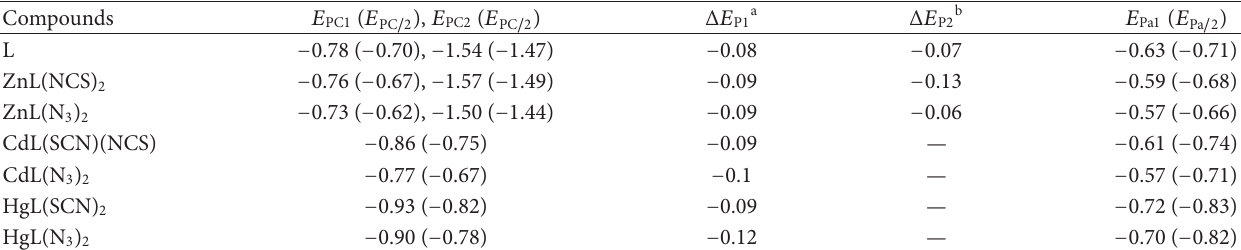
T 3: Electrochemical data of ligand and complexes.